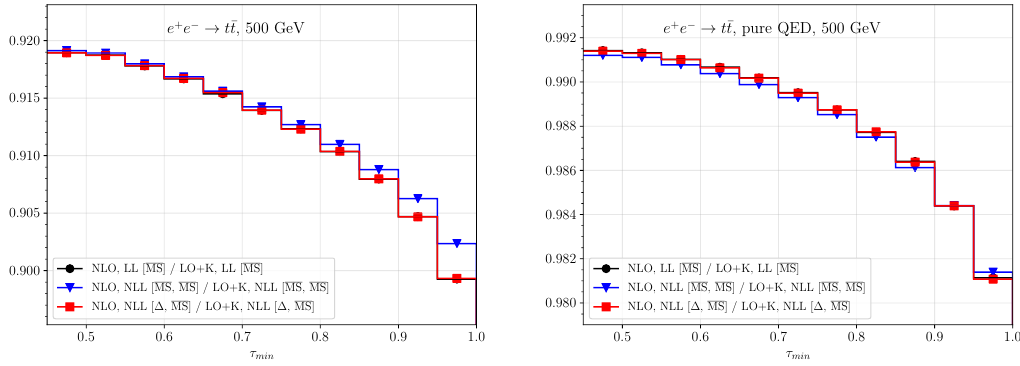
Figure 13 . As in figure 12, for t ¯ t production in the full SM (left panel) and in QED (right